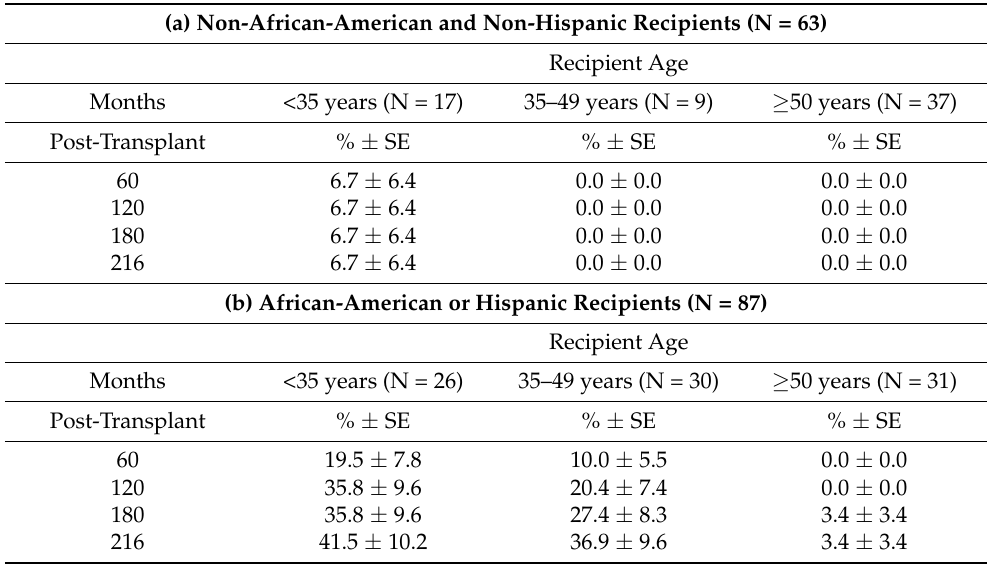
Table 4. Cumulative incidence function (CIF) estimates of the percentages experiencing GFNA, stratified by recipient age (<35, 35–49, and ≥ 50 years) and recipient race/ethnicity (non-African- American and non-Hispanic vs. African-American or